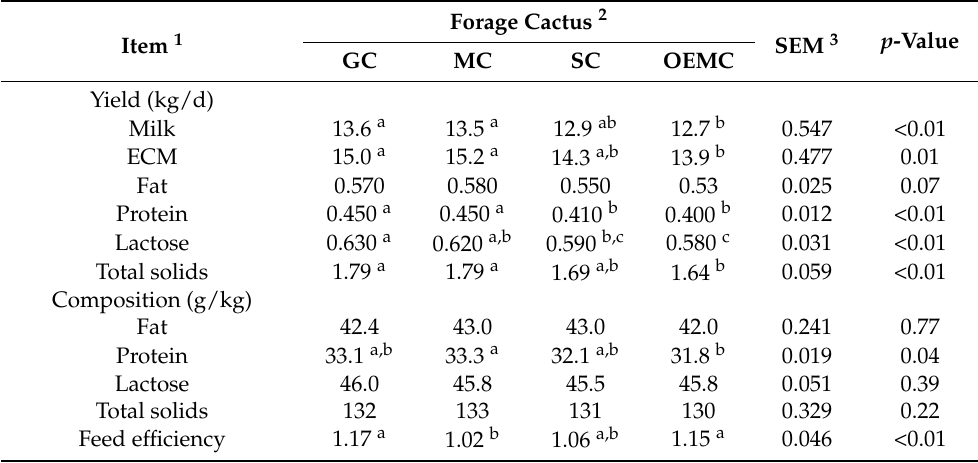
Forage Cactus 2